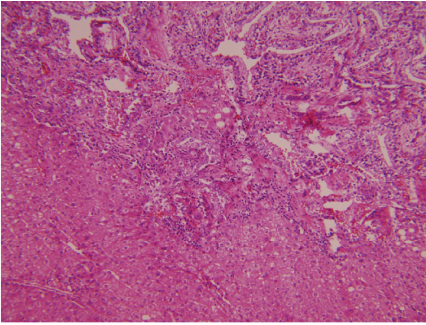
Figure 1: Tumor and surrounding liver parenchyma.